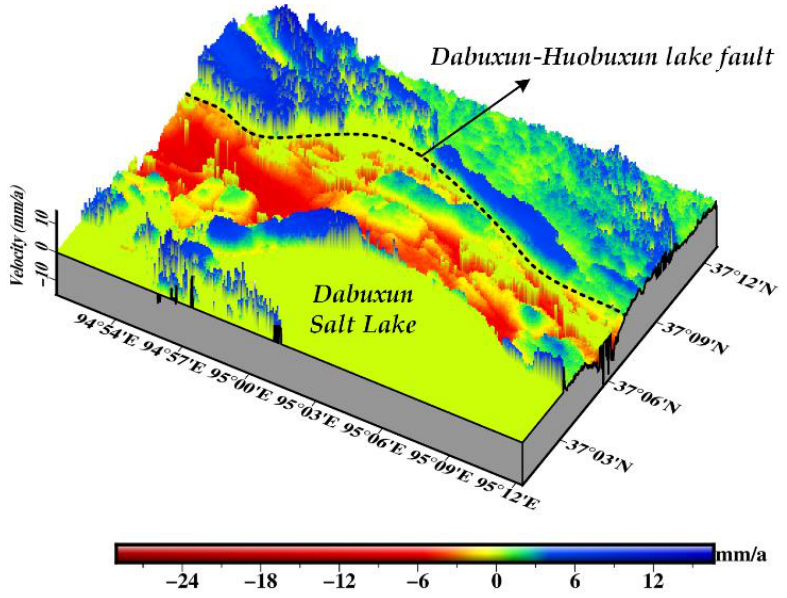
Figure 10. 3D view of the deformation velocity in area (a) which is depicted in Figure 7, the black dotted line in the middle indicates the Dabuxun-Huobuxun lake fault.